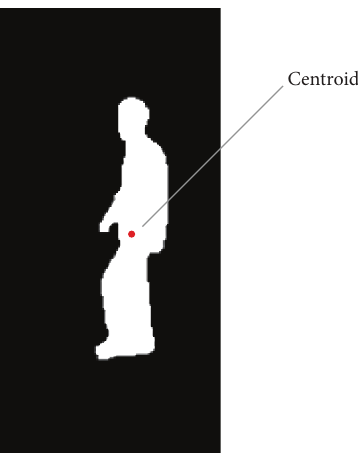
Figure 1: The centroid of a